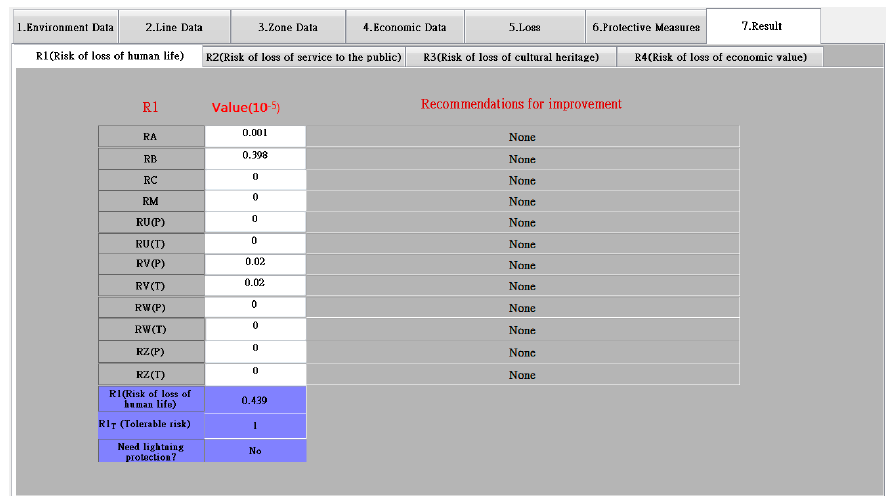
Figure 8. The R1 after using protection measures.